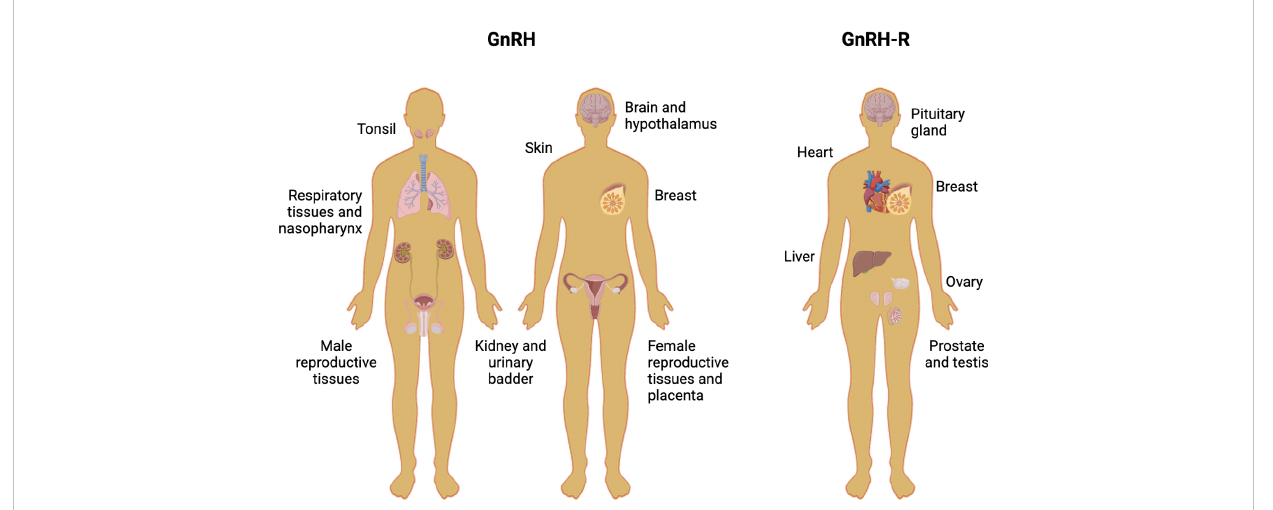
FIGURE 2 Human tissues that express GnRH and GnRH-R. The picture shows different human non-tumoral tissues in which the protein levels of GnRH and GnRH-R have been